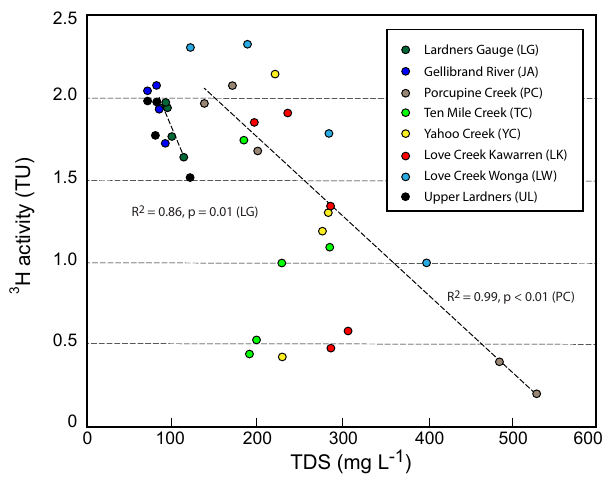
Figure 5. 3 H activities as a function of TDS for all catchments (data from Supplement). Strong inverse correlations between 3 H activi- ties and TDS exist for Lardiners Gauge and Porcupine